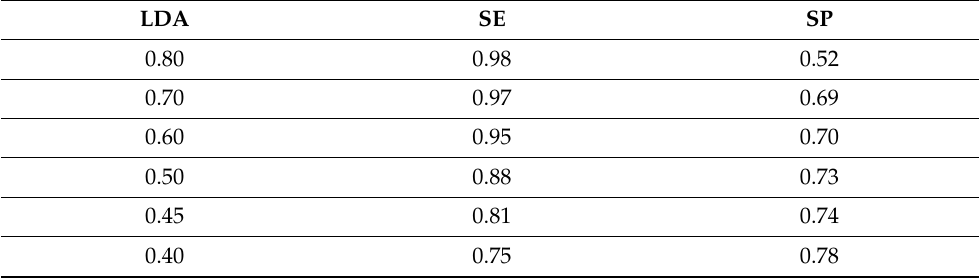
Table 4. Calculated selection of sensitivity (SE) and specificity (SP) of XBCM in high grade cases using different